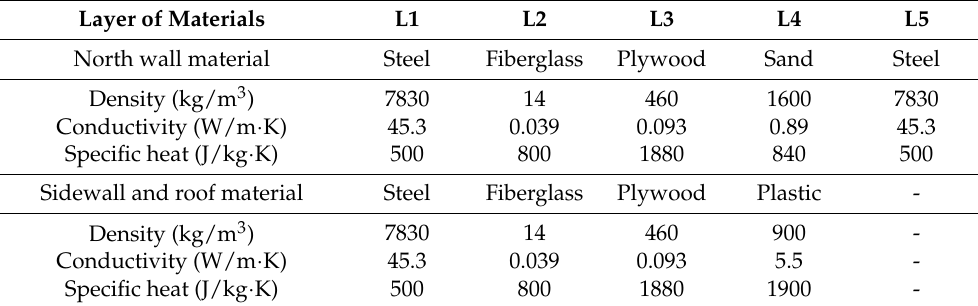
Table 1. Thermal properties of wall and north roof materials from exterior to interior layers.